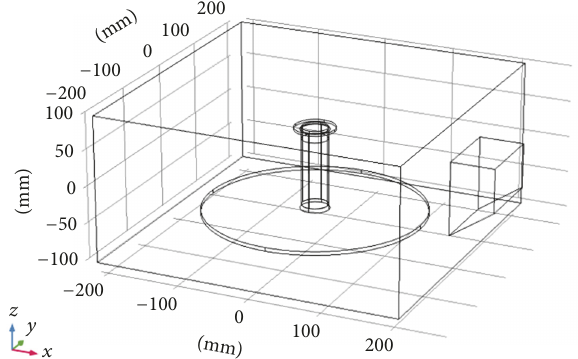
Figure 2: Schematic diagram of microwave workstation and extrac- tion vial